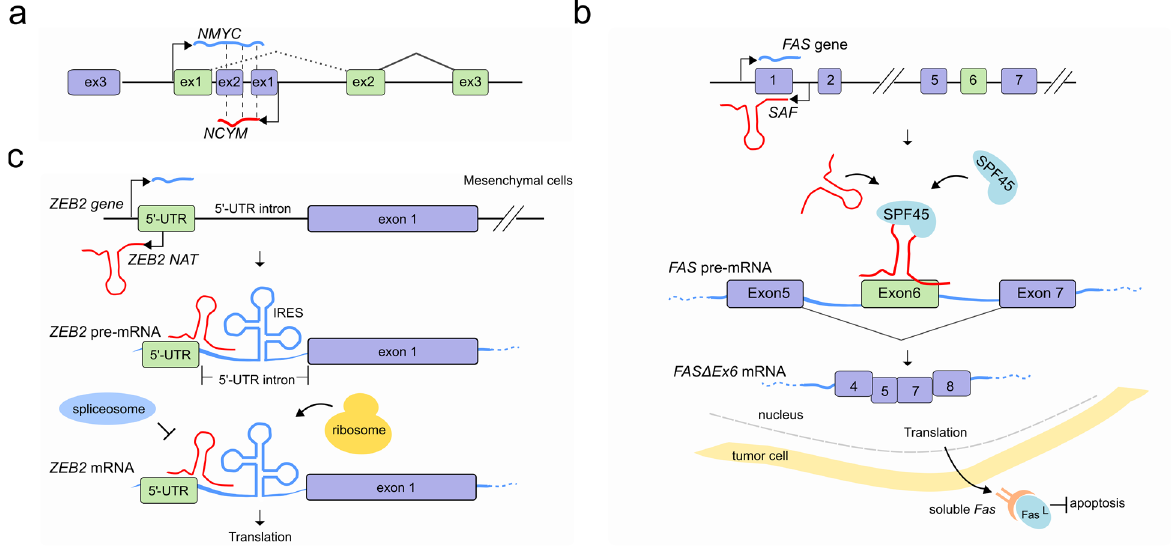
Figure 4. LncRNAs regulate pre-mRNA splicing through an RNA-RNA interaction. ( a ) NAT (red) at the NCYM gene modulates splicing of the NMYC mRNA (light blue) forming a sense-antisense RNA-RNA duplex which results in an intron-retained NMYC mRNA isoform population. ( b ) In tumor cells the natural antisense SAF (red) is transcribed from the first intron of FAS gene and interacts with both FAS pre-mRNA (light blue) at 5–6 and 6–7 exon junctions and the human SFP45 to facilitate the AS and exclusion of exon 6. The accumulation of the exon 6-skipped alternatively spliced variant of FAS pre-mRNA ( FAS Δ Ex6 mRNA) leads to the production of a soluble Fas (sFas) protein that binds FasL and makes tumor cells resistant to FasL-induced apoptosis. ( c ) After EMT, Snail1 transcription factor induces the co-transcription of ZEB2 NAT (red) in mesenchymal cells. ZEB2 NAT hybridises with a region of the ZEB2 pre-mRNA (light blue) encompassing the 5' splice site of a 3 kb-long 5'-UTR intron. This RNA-RNA duplex prevents both the binding of the spliceosome and the subsequent removal of the 5'-UTR intron. The resulting mRNA contains the full isoform of the 5'-UTR, including an internal ribosome entry site (IRES) proximal to the ZEB2 AUG, which favors translation. In absence of ZEB2 NAT (epithelial cells) instead the removal of the 5'-UTR intron results in an mRNA containing a sequence that inhibits scanning by the ribosomes and therefore prevents translation of ZEB2 protein (not shown).